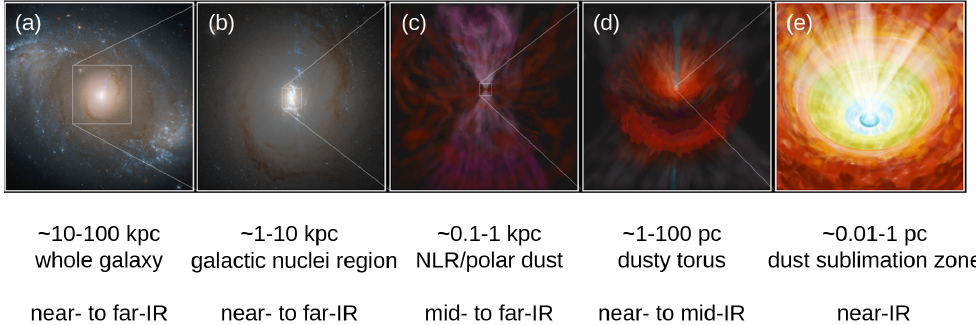
Figure 1. Illustration of various components that can contribute to the AGN IR emission at different scales, with the archetypal AGN in NGC 4151 as an example. From the left to right, Panel ( a ): NGC 4151 galaxy image from HST. ∗ Stars contribute the near-IR (1 < λ < 5 µ m) emission and HII regions can emit strongly in the mid-IR (5 < λ < 30 µ m) and far-IR (30 < λ < 500 µ m). Panel ( b ): the inner 5 kpc region of NGC 4151 as revealed by HST WFC3 images. ∗ We can directly see the narrow- line-region (NLR) clouds near the central bright AGN, projecting along two directions, as well as two dust lanes and numerous small dust streams at different locations. Panel ( c ): schematic of the dust components at 1 kpc scale, featuring the NLR and polar dust in the AGN ionization cone. Outside this cone, relatively cool dust is shielded by the torus from the direct heating of the AGN. Panel ( d ): schematic of the dust structures at ∼ 1–100 pc scale, featuring a flared torus with possible turbulent/outflowing signatures and winds feeding the region of the NLR, which often dominate the AGN-heated dust emission from 6 to 40 µ m. We also indicate a sub-mm torus extension (the circumnuclear disk) on a ∼ 40–60 pc scale detected by ALMA around many AGNs [10], not observed in NGC 4151 because it is not readily accessible to ALMA. Panel ( e ): schematic of the innermost region of the torus over ∼ 0.01–1 pc scales, featuring a likely turbulent disk; here, dust grains of graphite and silicates can be heated to their sublimation temperatures of 1500–2500 K and 900–1000 K, respectively, resulting in the AGN hot dust emission peaking around 2–4 µ m. Modified from a figure in Lyu & Rieke [11]. (*—figure modified based on the original version from https://commons.wikimedia.org/wiki/File:NGC_4151_-_HST.png, (accessed on 25 May